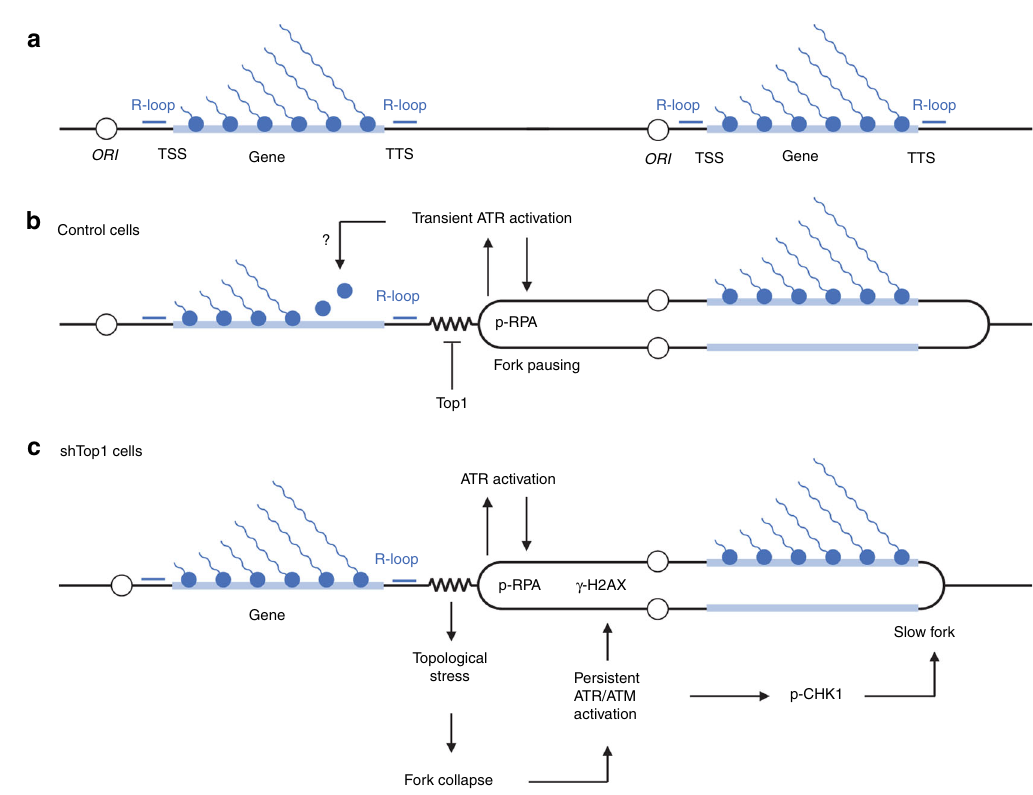
Fig. 6 Model of the regulation of TRCs in the human genome. a Highly expressed genes form co-transcriptional R-loops at TSS, TTS and to a lesser extent in gene bodies. Replication origins are frequently located upstream of TSS. b Initiation from upstream origins ensures that R-loops at TSS and gene bodies are preferentially replicated codirectionally, which would limit HO con fl icts. Forks progressing in the opposite direction pause when they encounter the TTS of highly expressed genes, presumably because of the accumulation of positive supercoiling. Transient fork pausing activates ATR and leads to the phosphorylation of RPA32 on S33. ATR may also promote the displacement of RNA polymerases ahead of the paused fork. c In the absence of Top1, the accumulation of torsional stress may lead to fork collapse and to the sustained activation of ATR/ATM. This would in turn slowdown fork progression throughout the